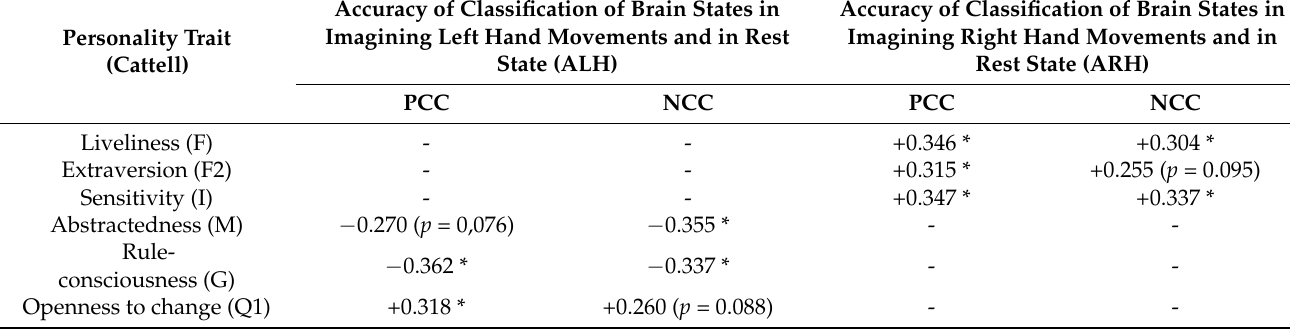
Table 1. Correlations between personality traits and the accuracy of classification of brain states during imagination of hand movements comparative to the rest (data of all 44